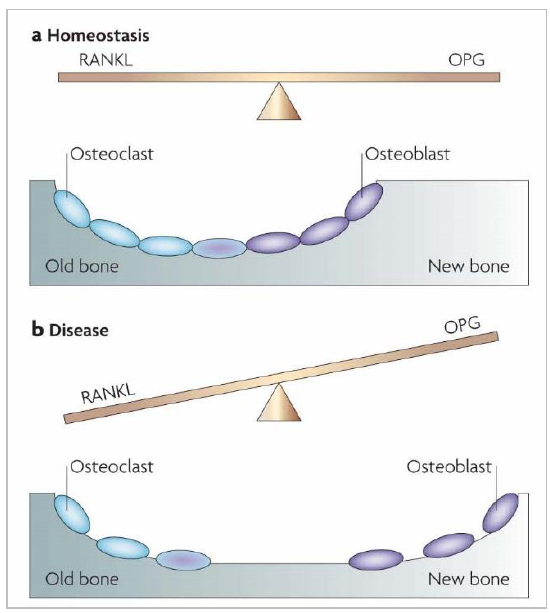
Figure 5. The NF- κB model of bone resorption during periodontal and peri -implant diseases